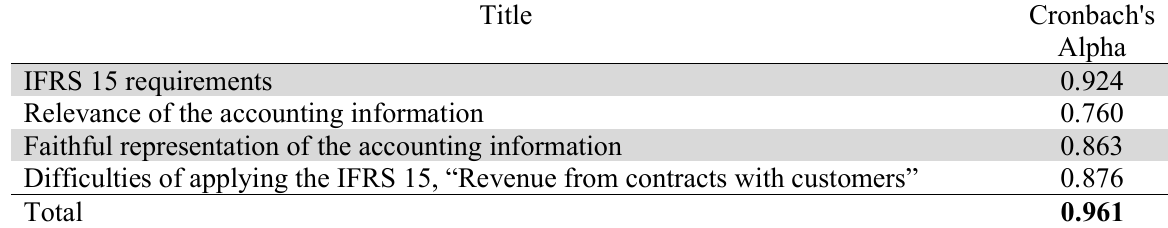
Results of the descriptive analysis of the study independent variable (IFRS 15)